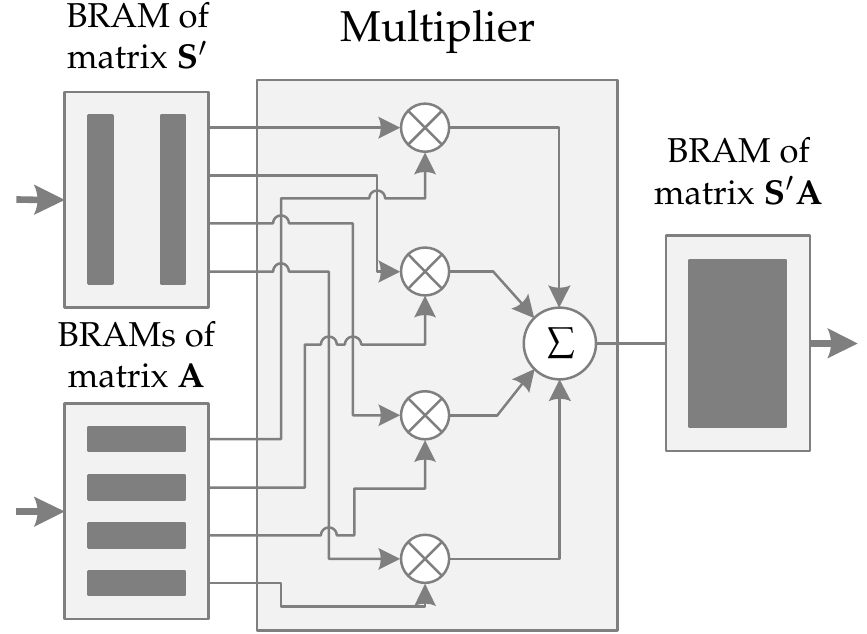
Figure 7. Schematic representation of S (cid:48) A arrows 16-bits buses. Control signals have been